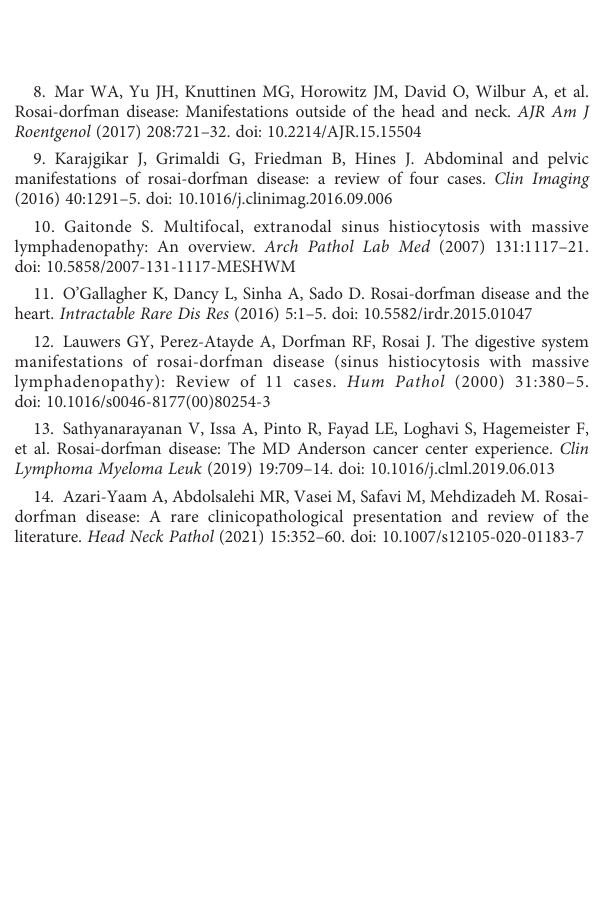
SUPPLEMENTARY FIGURE 1 Histological fi ndings of the pelvic lesion. (A, B) Hematoxylin and eosin staining revealed lymphoplasmacytic in fi ltration in fat tissue and scattered histiocytes with emperipolesis. (C) Immunohistochemical analysis for S- 100 protein showing histiocytes with emperipolesis. Original magni fi cations: × 100 (A), × 400 (B, C)